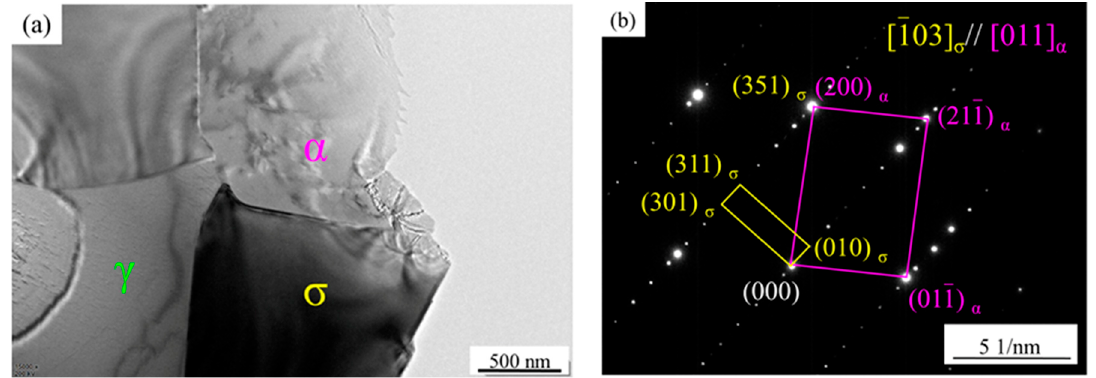
Figure 4. TEM images ( a ) and SAED patterns ( b ) of precipitates of the specimens after solution treatment at 1040 °C.